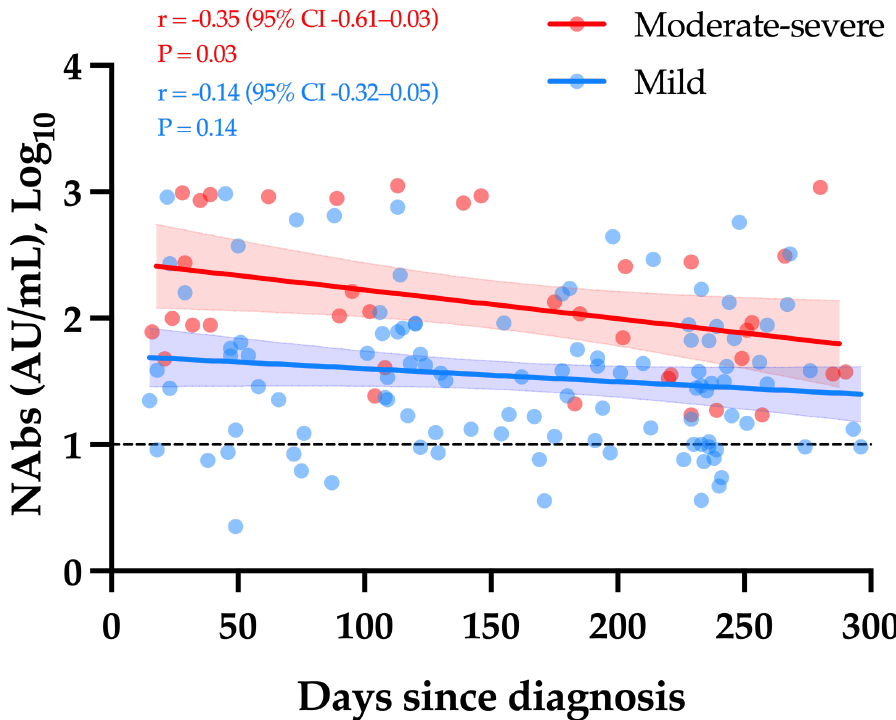
Figure 2. The kinetics of NAbs in moderate–severe versus mild COVID-19 (group 1). The black dotted line corresponds to the positivity threshold of 10 AU/mL.